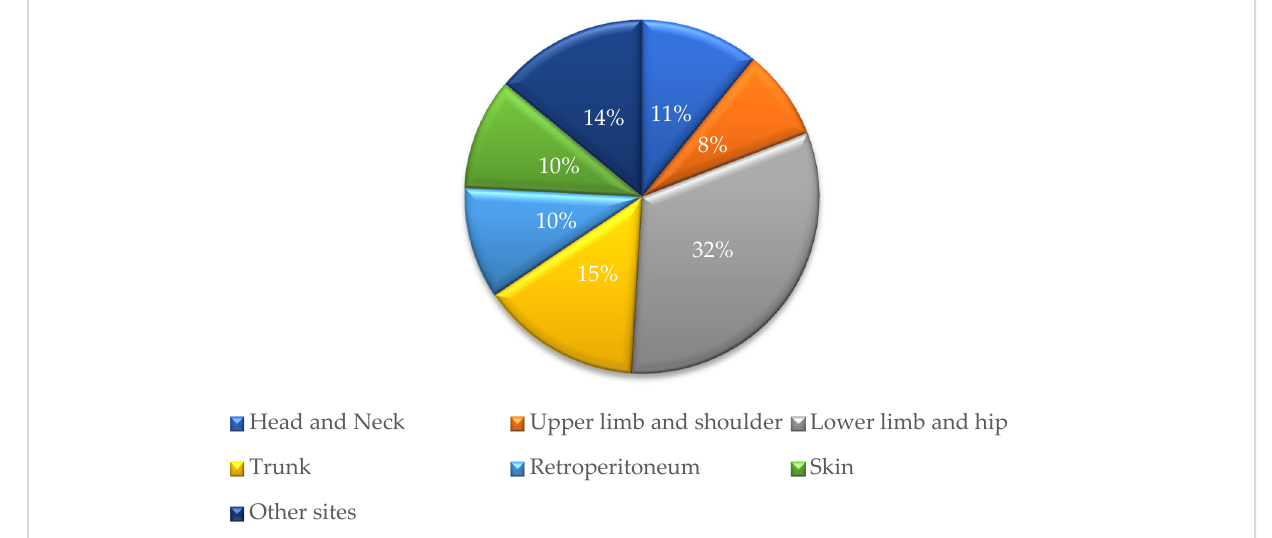
Figure 4. Distribution of soft tissue sarcoma by body site.